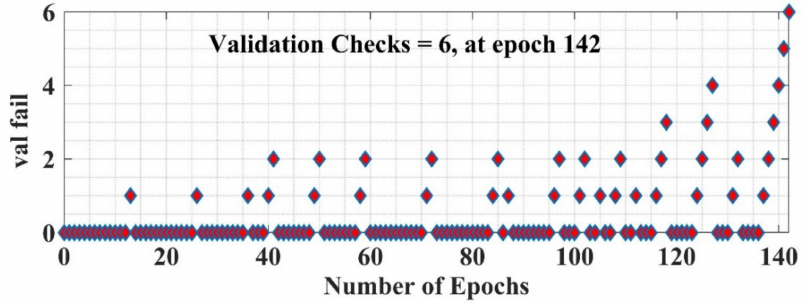
Figure 23. NN’s validation curve w.r.t. number of epochs.